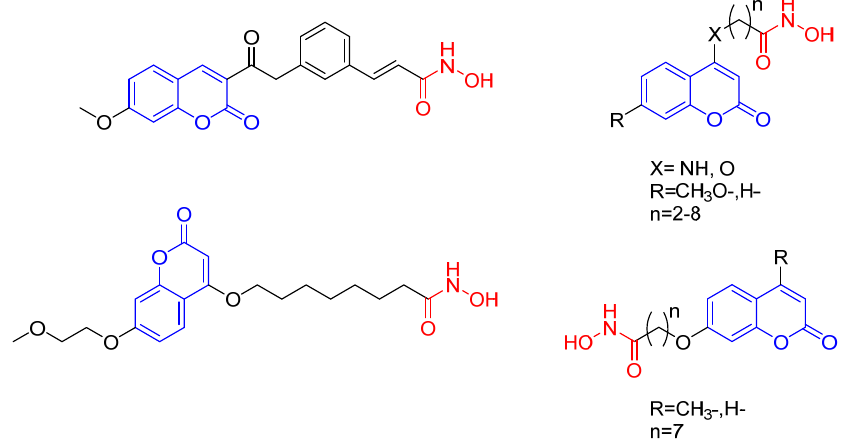
Figure 2. Examples for structures of coumarin and hydroxamic acids moieties that indicates the effectiveness in the application as anticancer agents.